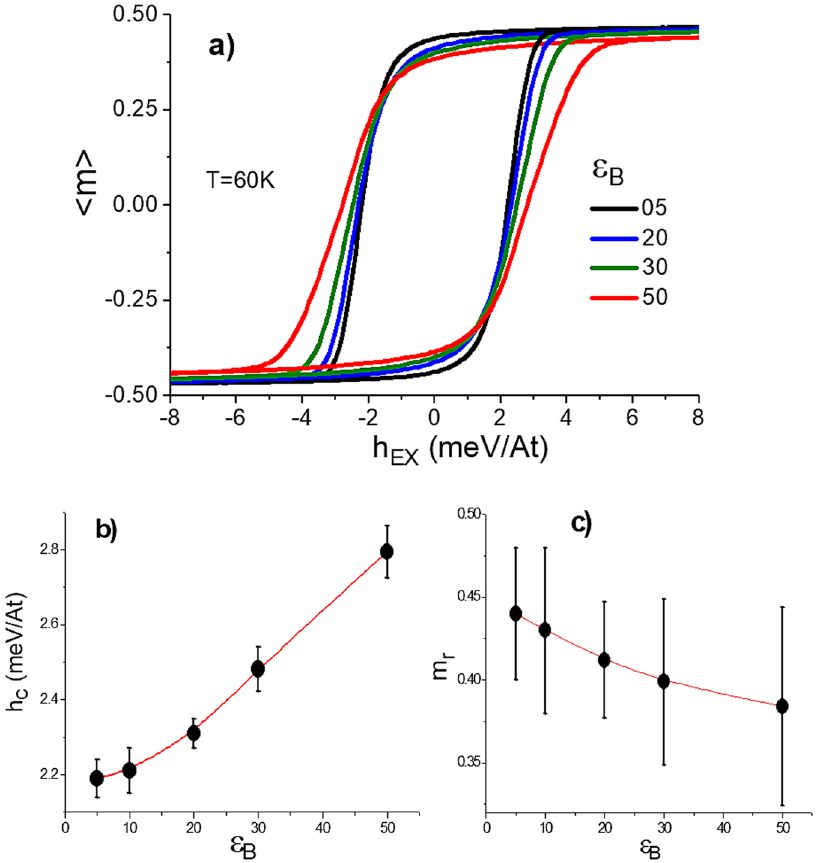
Figure 8. ( a ) Hystesis loops at different values of ε ε , respectively. Increments in anisotropy strength promote a remarkable coercive force B